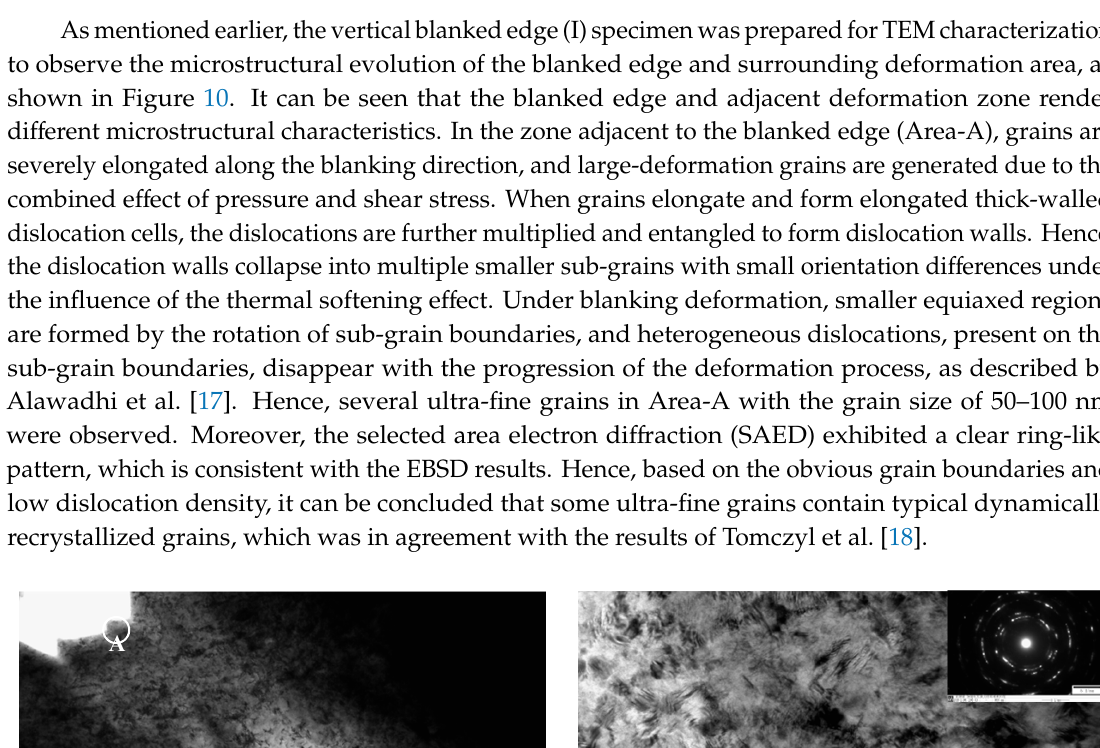
Figure 9. Texture pattern of the deformed zone in the blanked edge (SPM 3000). ( a ) Orientation distribution function (ODF) map; ( b ) Pole Figure map; ( c ) Inverse Pole Figure map.